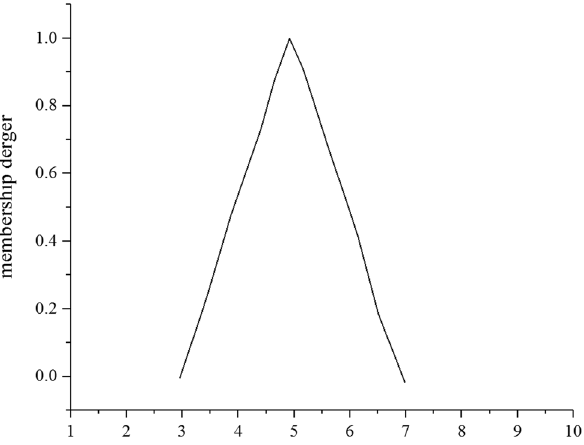
Figure 2: Triangle membership